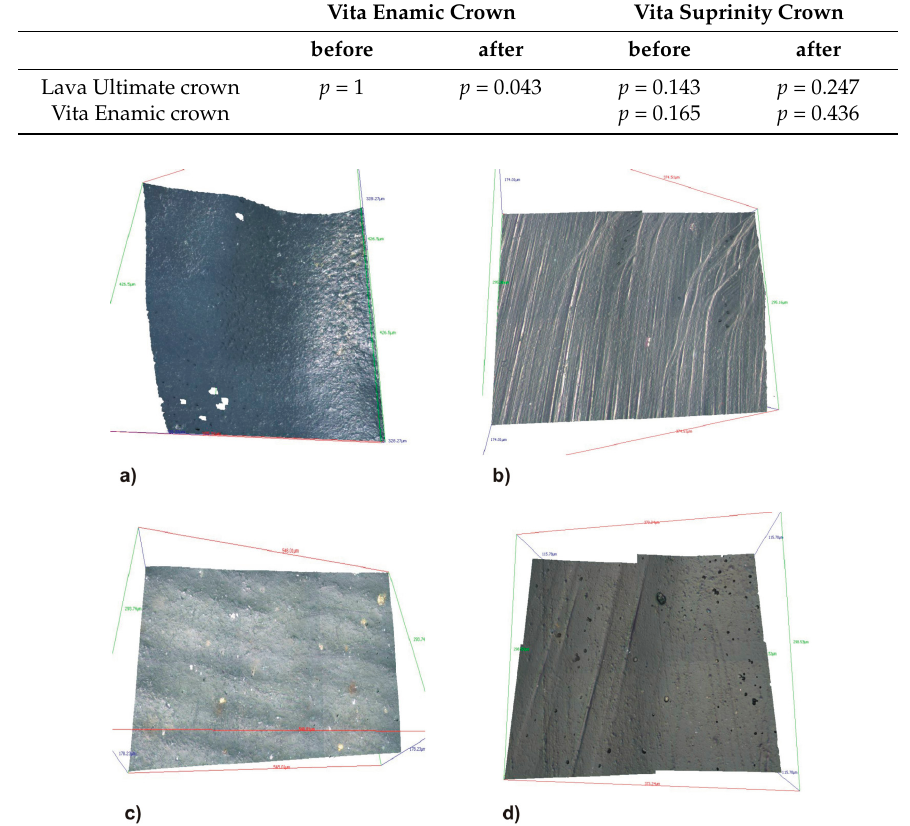
Table 2. Results of the Mann-Whitney U test comparing the full ceramic CAD/CAM crowns occlusal surface roughness between the tested material groups before and after the chewing simulation.